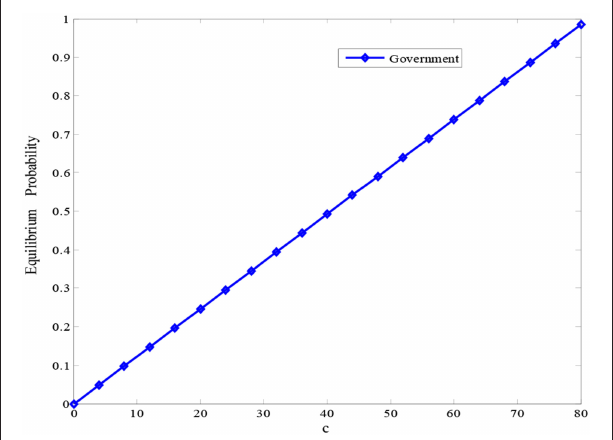
FIGURE 8 | The government’s equilibrium probability as a function of c